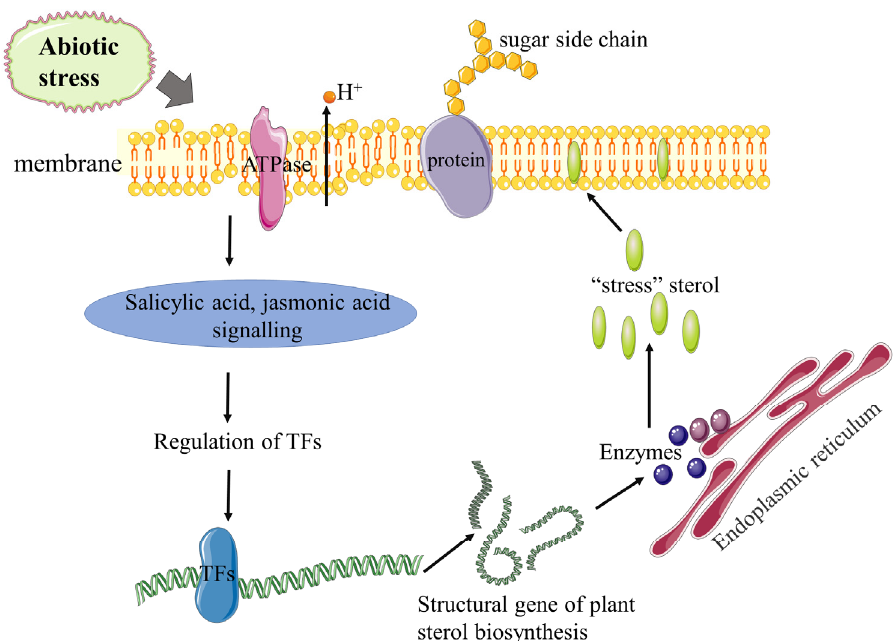
Figure 4. Role of plant sterols in response to abiotic stress. Under abiotic stress, the structure of the membrane is destroyed, which affects the permeability of the membrane and the activity of the membrane-bound protein, causing the loss of H + . Transcription factors are regulated by corresponding hormone signals to regulate the expression of structural genes of sterol biosynthesis to affect the content of “stress” sterols and ultimately maintain membrane stability.